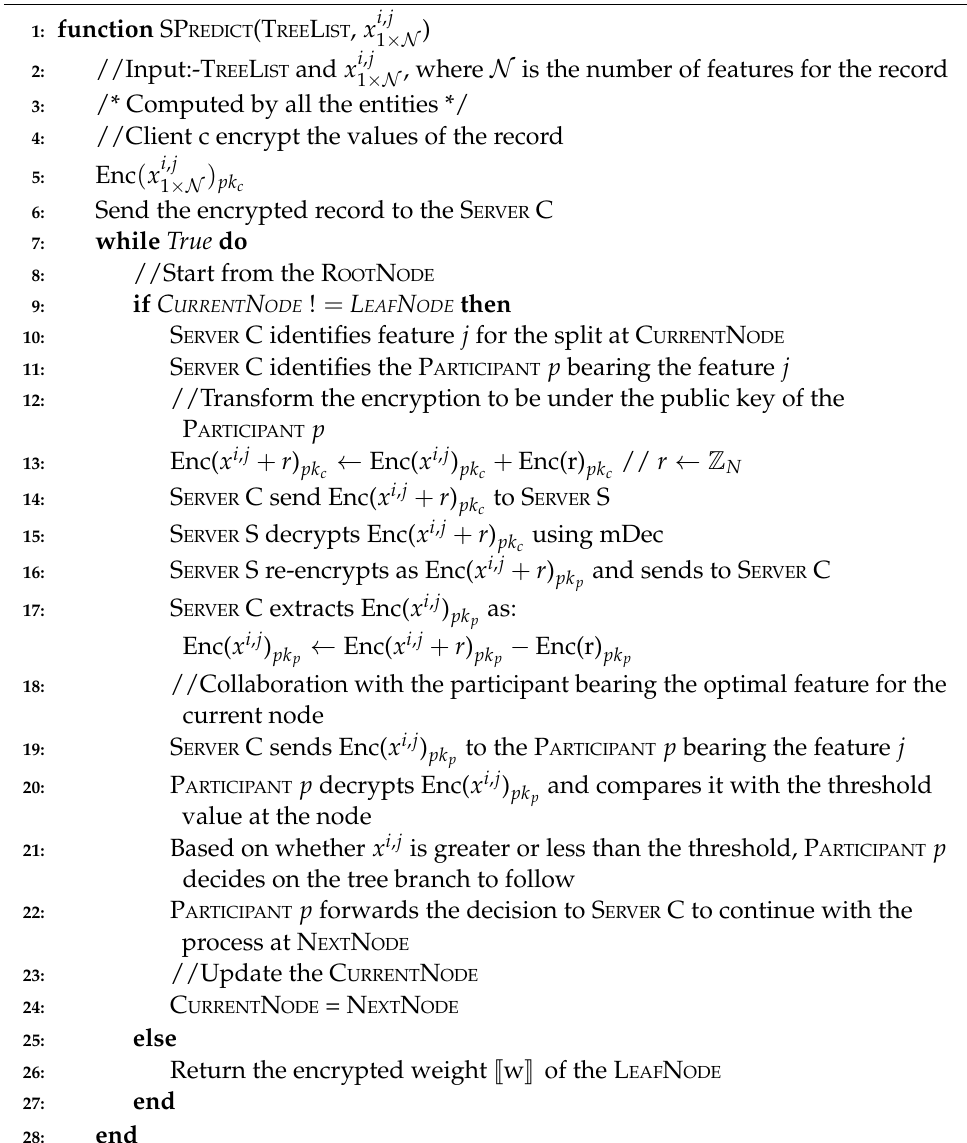
Algorithm 6: Secure Prediction